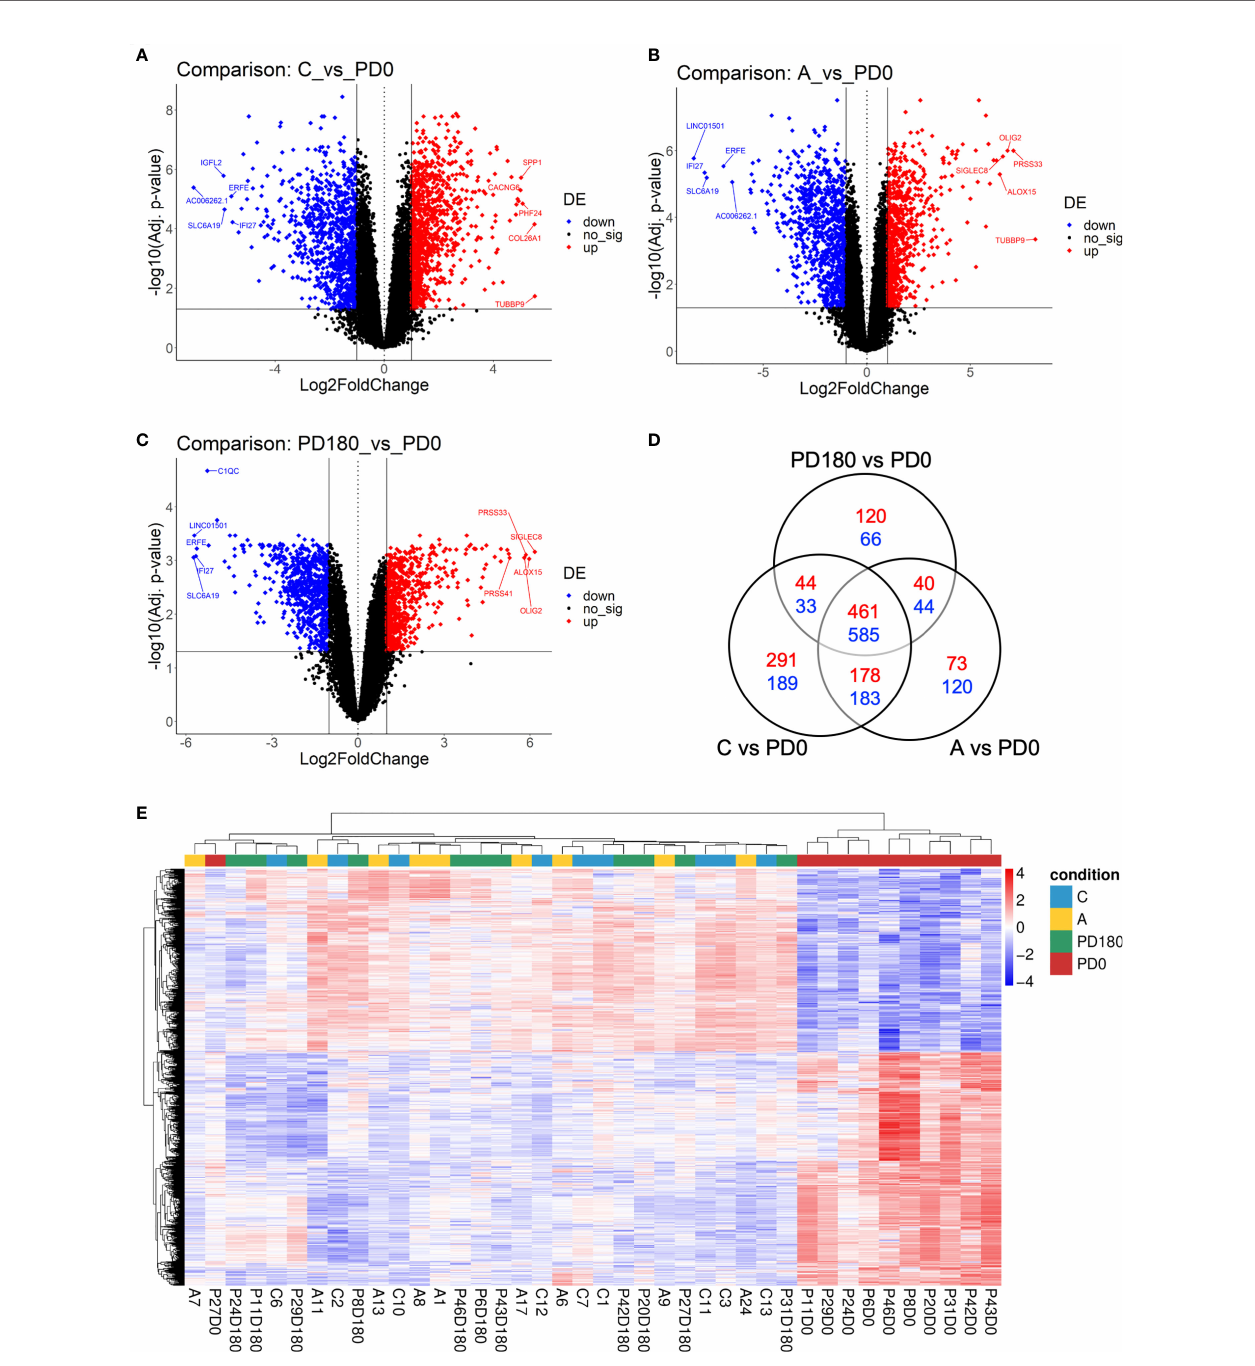
FIGURE 3 | Differential expression analysis comparing VL patients to nondiseased patients identi fi ed hundreds of differentially expressed genes (DEGs). Volcano plots highlighting genes signi fi cantly regulated (FDR <0.05, horizontal threshold line set on y-axis) in the comparisons C vs. PD0 (A) , A vs. PD0 (B) and PD0 vs. PD180 (C) . Vertical lines at -1 and +1 on the x-axis indicate the expression level criteria of fold decrease or increase, respectively, applied to DEGs that were further analyzed (all genes colored in blue or red); (D) Venn diagram displaying the number of exclusive DEGs for each comparison, as well as the number of shared DEGs among them. Dashed squares indicate the DEG lists used as subsets of prioritized genes in the mRNA-lncRNA coexpression pro fi le analysis; (E) Heatmap of 1,045 DEGs shared among the three comparisons (suggested to be the gene signature of VL disease status), depicting the clustering of samples in two major groups: VL patients (PD0 labels, in red), the very consistent cluster on the right side and a heterogeneous cluster encompassing the nondiseased groups ( C, A and PD180 labels, in blue, yellow and green, respectively) split into minor clusters. Z scores of cpm read counts were used, and a graded color scale from red to blue indicates whether the level of gene expression was above or below the mean (i.e., up- or